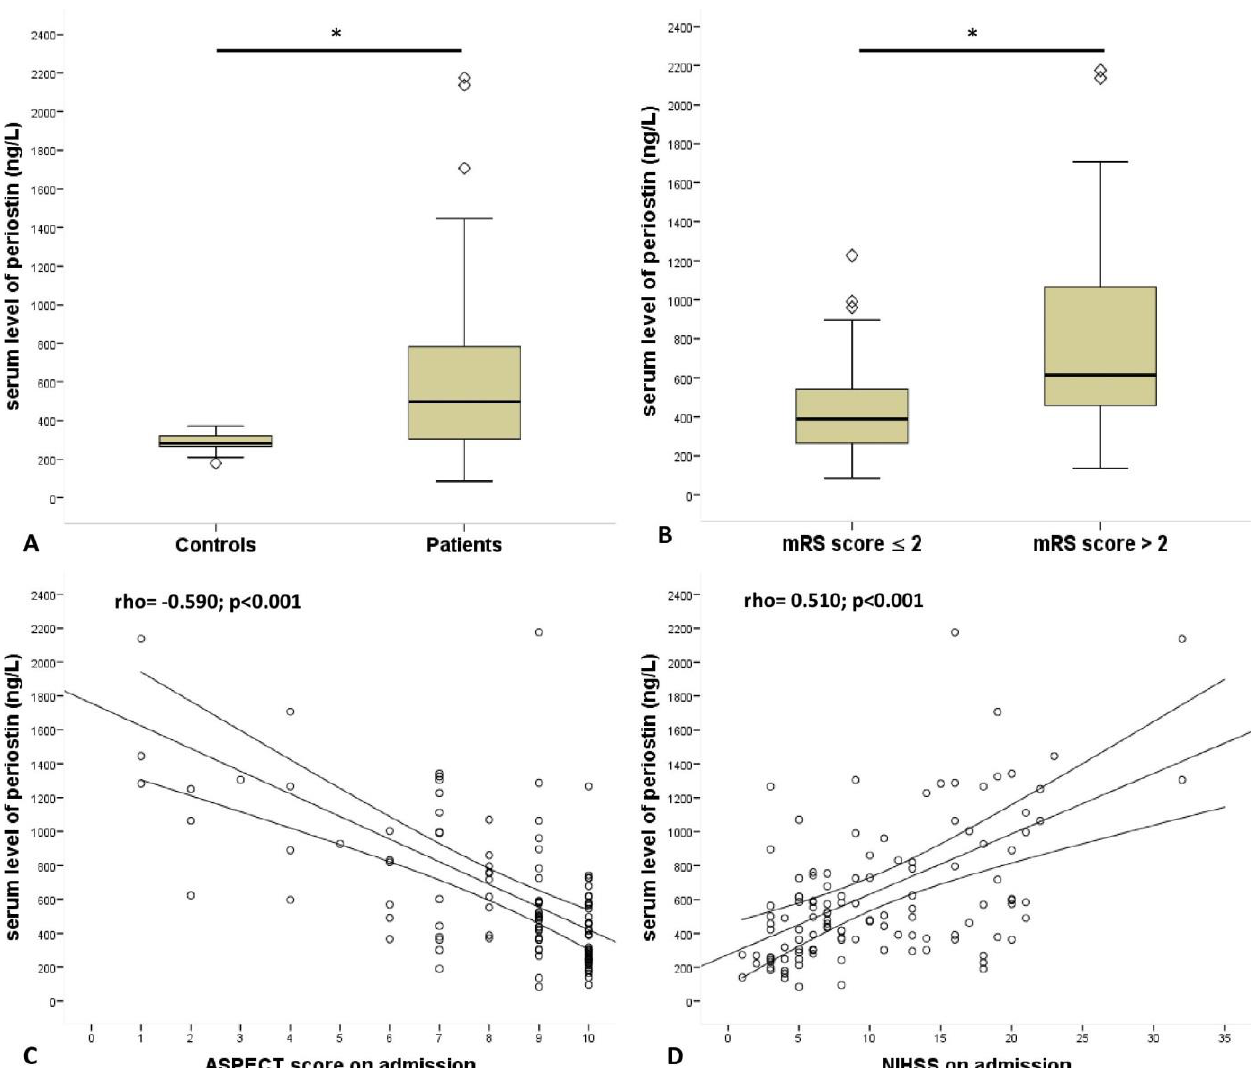
Figure 2. Comparison of serum periostin level ( A ) among patients with stroke and controls, ( B ) between patients with favorable outcome (mRS ≤ 2) vs. unfavorable outcome (mRS > 2) on Day 90 follow-up. Correlation of admission serum periostin level with ( C ) ASPECT score measured on admission and ( D ) NIHSS score recorded on admission. Serum periostin level was measured at 24 h after stroke onset. * p -value < 0.001. ASPECT, Alberta stroke program early CT score; mRS, modified Rankin score; NIHSS, National Institutes of Health Stroke Scale. Statistical analysis were performed with Mann–Whitney U-test ( A , B ) and using Spearman rank correlation ( C , D